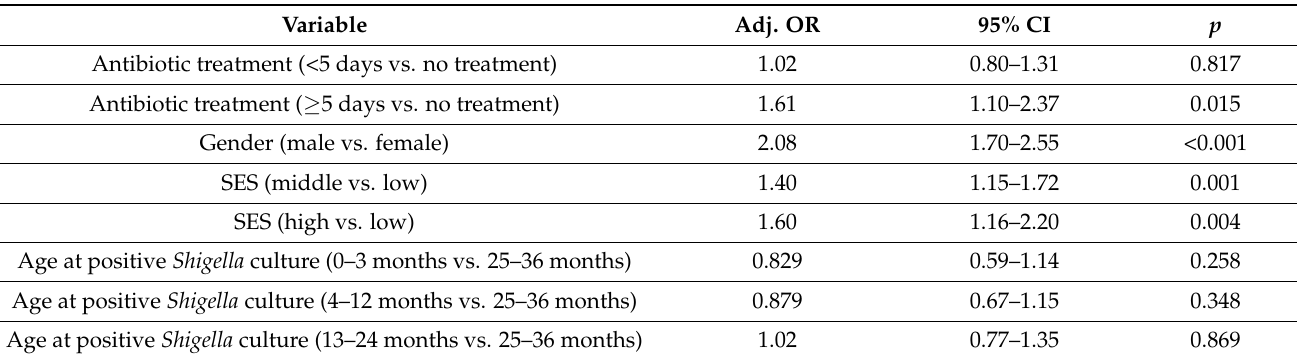
Table 3. Multivariable analysis with adjusted odds ratio (OR) and 95% confidence interval (95% CI) for the independent association between antibiotic treatment for Shigella gastroenteritis and ADHD ( n =